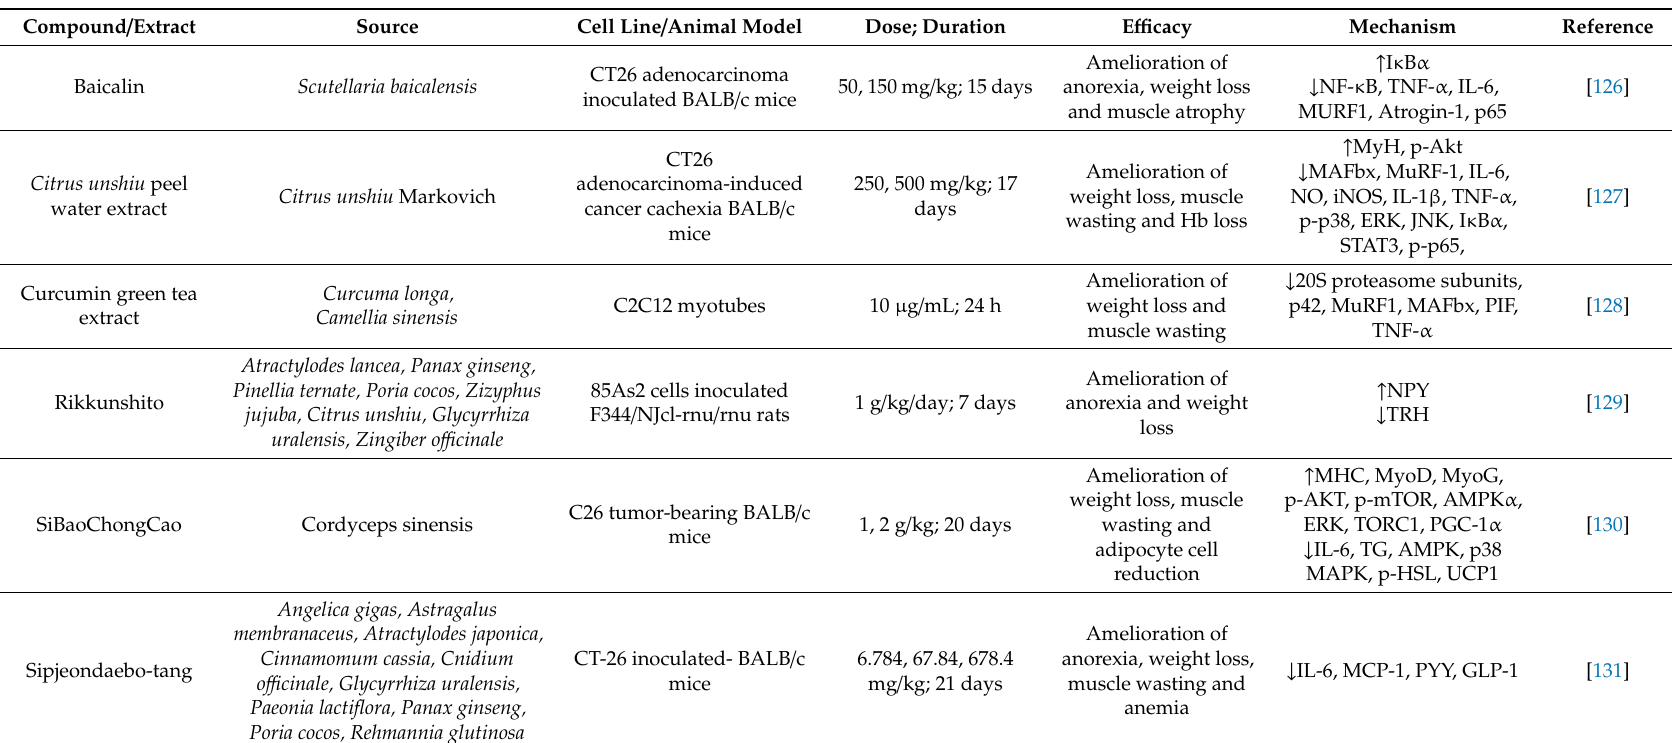
Table 4. Plant-derived drugs and